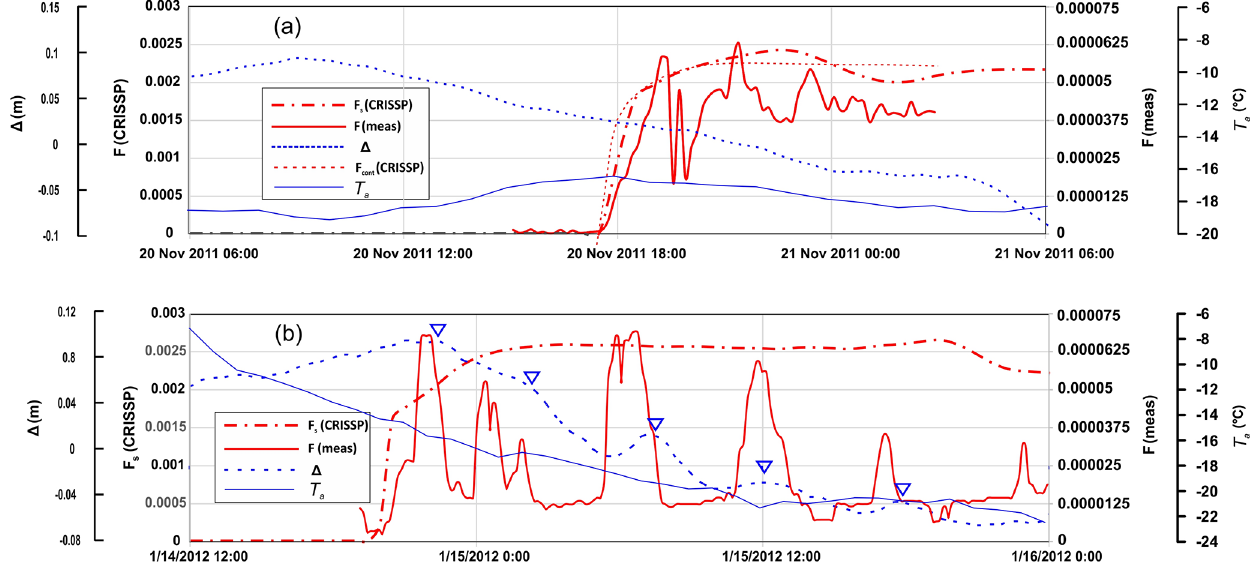
Figure 5. Comparisons of fractional volumes as measured ( F (meas)) and simulated ( F s (CRISSP), ( F cont (CRISSP)) for (a) interval 1 and (b) interval 3. The F s (CRISSP) plots were shifted to later and earlier times by 12.65 and 15h, respectively, to facilitate coincident simulated and measured frazil onsets. The plot in panel (a) also includes F cont (CRISSP) depicting an artificially triggered simulation described in the text based upon fully contemporary post-onset environmental inputs. The measured and simulated fractional volumes represented, respec- tively, regions 2.3m above the SWIPS instrument and water column mean values. The additional, dotted, curves represent (cid:49) , the difference between 10-point running-average local water levels and levels simulated by CRISSP1D in the absence of anchor ice. The inverted triangles in panel (b) denote the central positions of anomalous anchor-ice-related water level peaks. Model air temperature inputs, T a , are also plotted in the